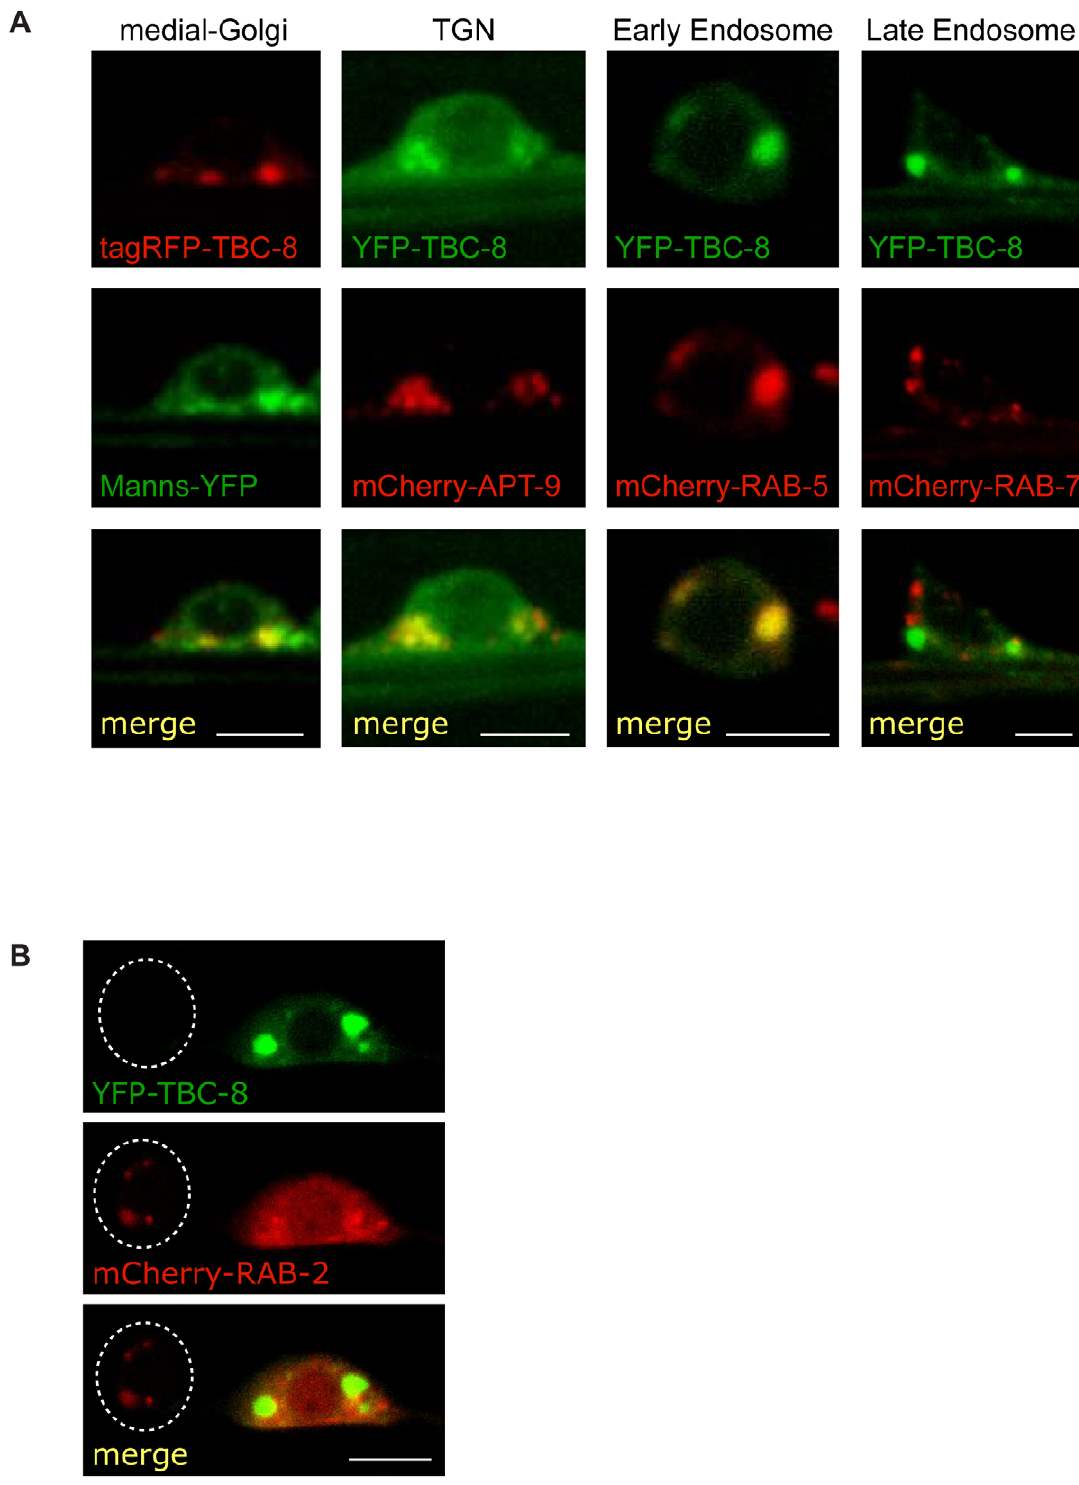
Figure 5. TBC-8 localizes to the Golgi-endosomal interface. (A) The subcellular localization of fluorescently-labeled TBC-8 expressed in motoneurons was analyzed by confocal microscopy. Fluorescently-labeled-TBC-8 localized partially with medial and trans-Golgi markers and showed full co-localization with the early endosomal marker mCherry-RAB-5. No co-localization to RAB-7-positive late endosomes was observed. (B) In motoneurons, mCherry-RAB-2 localizes to the Golgi (left cell body; cell boundary is highlighted by a dashed line). However, when YFP-TBC-8 is overexpressed, mCherry-RAB-2 is redistributed to the cytosol (right cell body). Manns: mannosidase II, TGN: trans-Golgi network. Scale bars represent 3 m m.